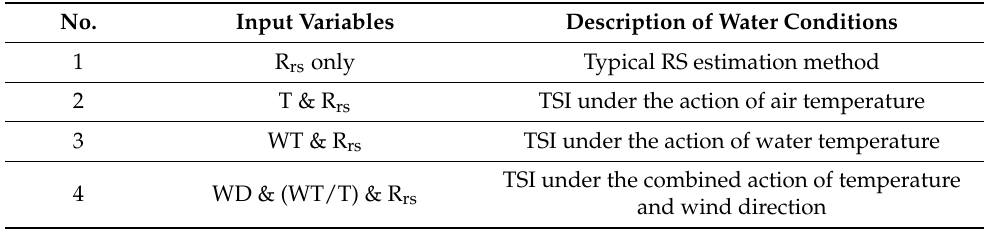
Table 1. Input variable combination